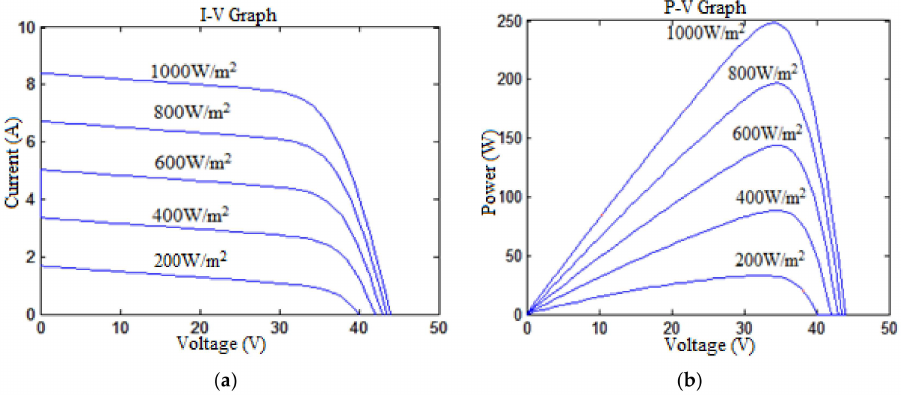
Figure 3. P–V characteristics graph for di ff erent irradiation levels. ( a ) shows the current versus voltage graph for di ff erent irradiation levels; ( b ) shows the power versus voltage graph for di ff erent irradiation